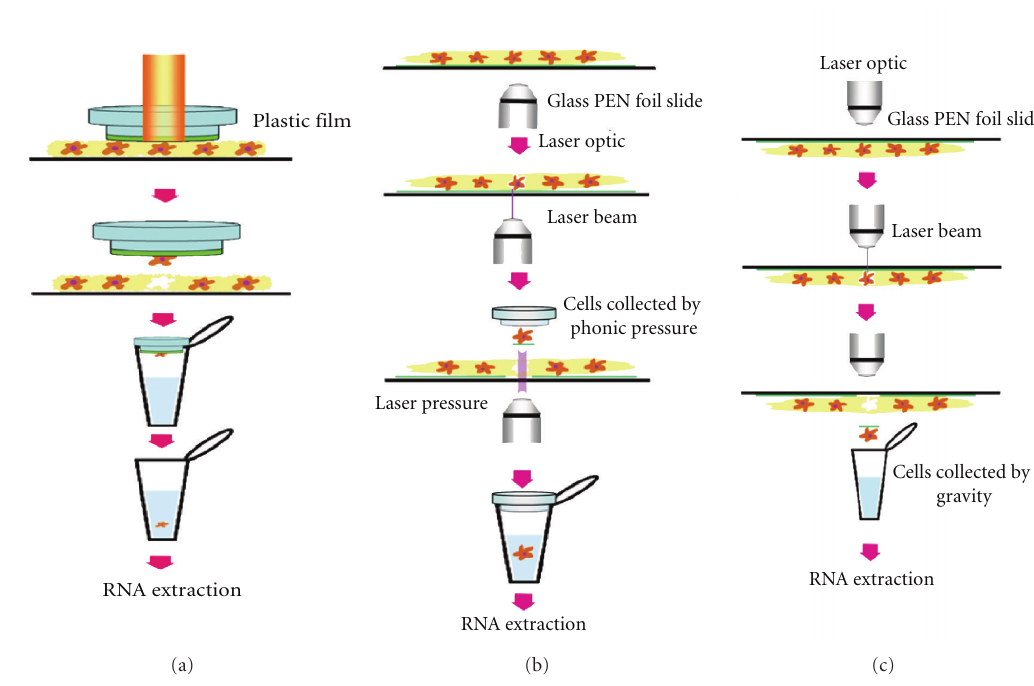
Figure 1: (a) Principle of the Arcturus laser capture microdissection. A plastic film is covered over the specimen. When the plastic film is removed, the dissected tissue by IR laser is attached to the film and isolated from the rest of the sample section. (b) Principle of the Zeiss’s PALM microdissection. The tissue section has been mounted on a PEN foiled slide. Then, UV laser beam focused and cut a contour around the area of the target tissue via inverted microscope. The dissected tissue is collected by photonic pressure; using laser pressure to lift the dissected tissue into a collecting cap is named laser pressure catapulting . (c) Principle of the Leica AS LMD microdissection. The tissue section that has been mounted on a PEN foiled slide is set upside down of the stage. Then, laser beam dissect the target tissue. The dissected tissue falls into collecting cap positioned under the